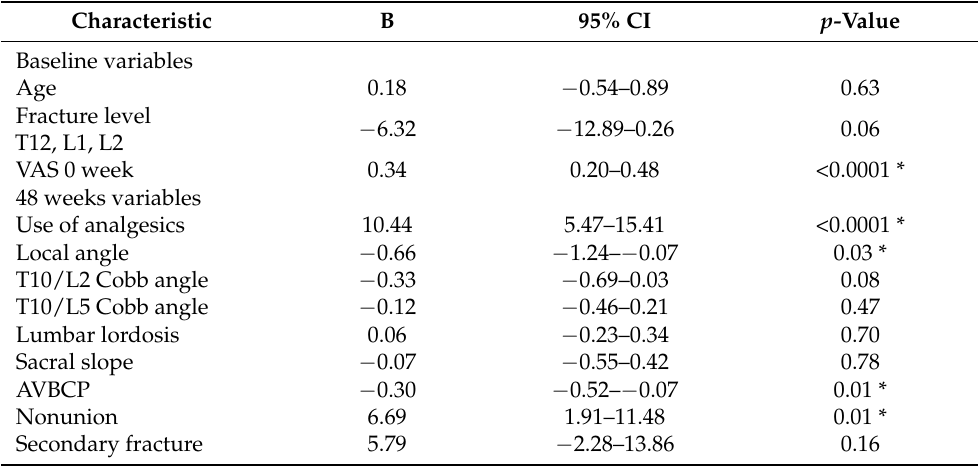
Table 2. Univariate regression analysis. Association of baseline and 48 weeks variables with low back pain at 48 weeks after OVF.